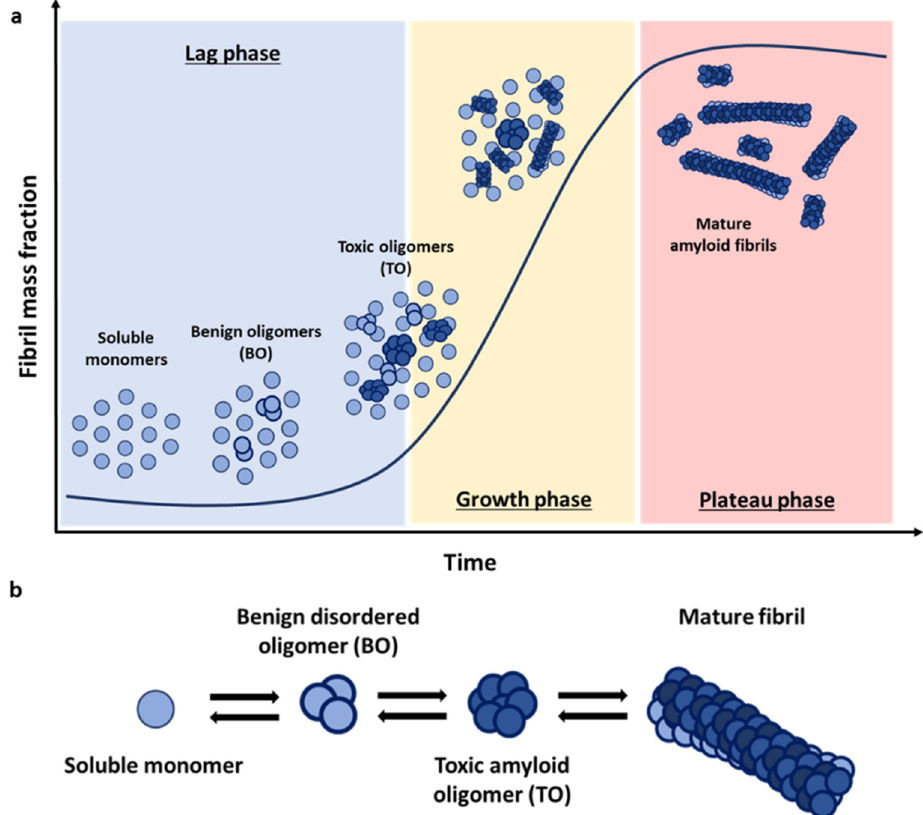
Figure 1. Schematic representation of amyloid formation process according to the nucleation–conversion–polymerization model. ( a ) Typical kinetics of amyloid fibril formation are presented as displaying fibril mass fraction versus time. Initially soluble protein monomers self-assemble in the initial lag phase to generate disordered, benign oligomers (BO), which convert into partially β -sheet structured, toxic oligomers (TO). The sigmoidal growth profile accounts for the greater ease of addition of protein monomers to stable preformed aggregates and the rate limiting nature of the nucleation step. Eventually, a plateau phase is reached as a consequence of monomer depletion. ( b ) A very simplified representation of the main structural groups of protein species present along the fibril formation process: monomers, benign oligomers, toxic oligomers, and